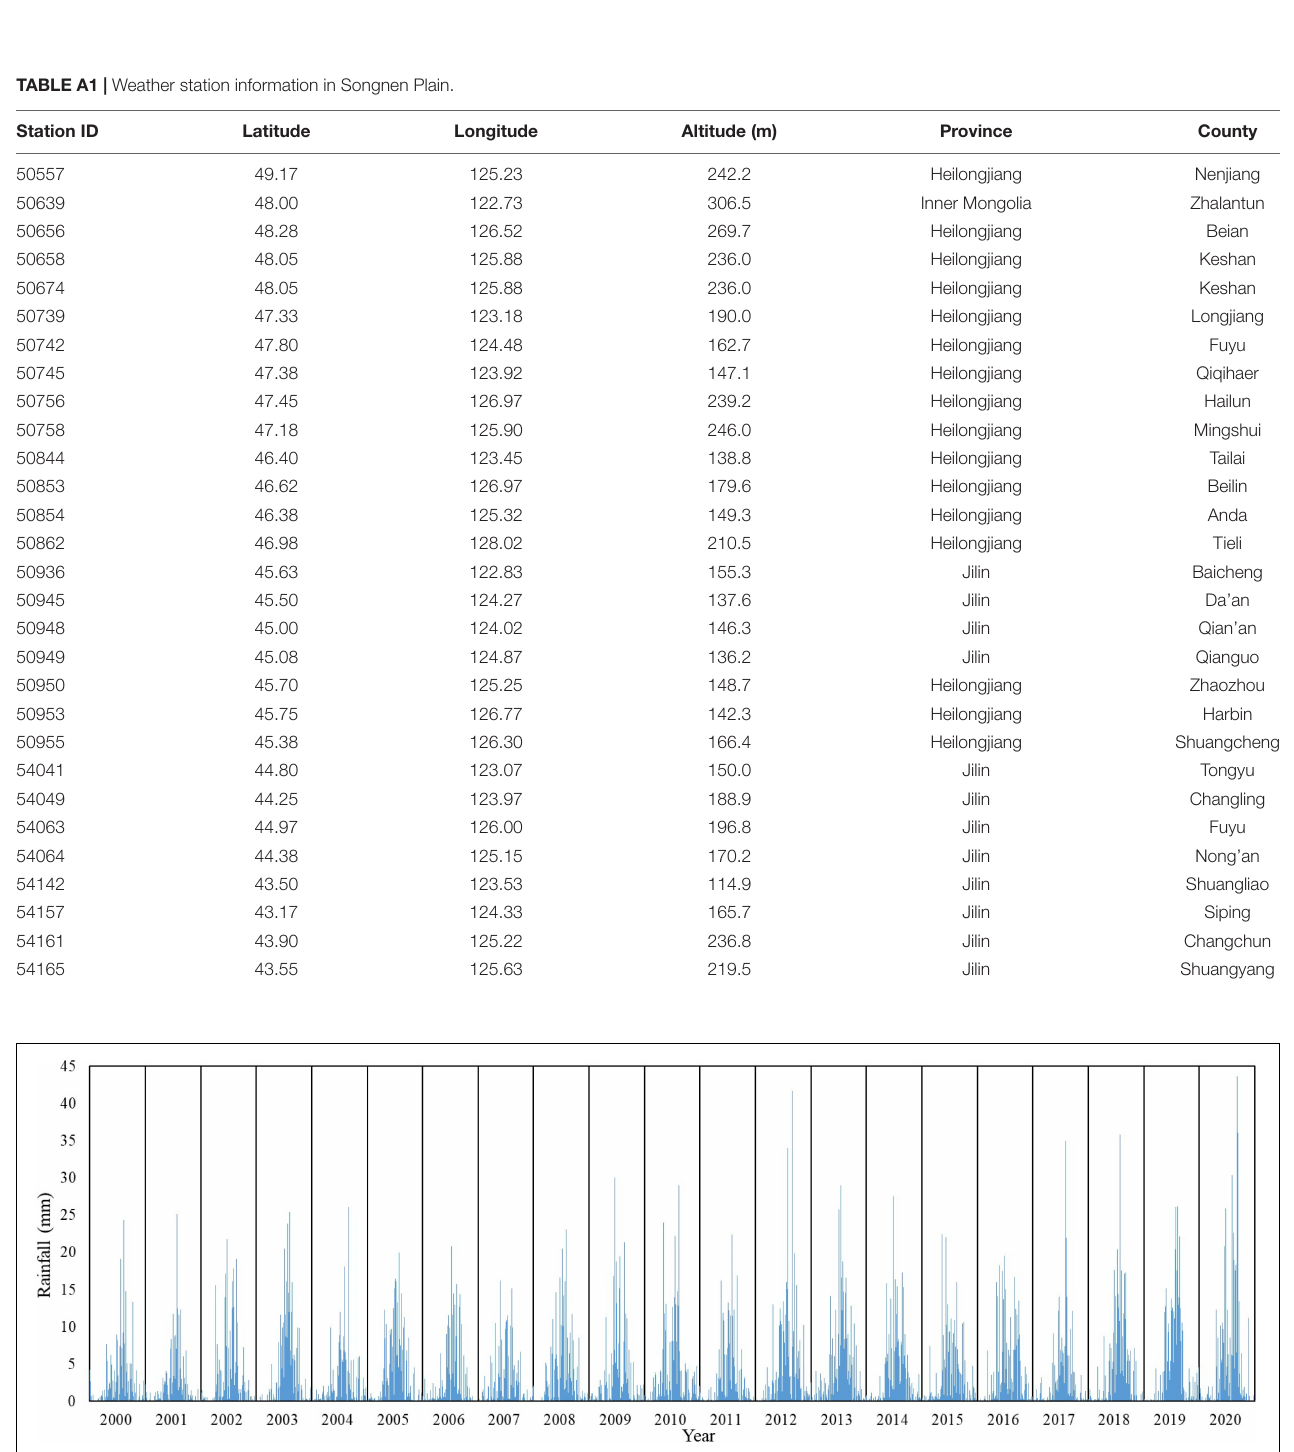
Frontiers in Plant Science |